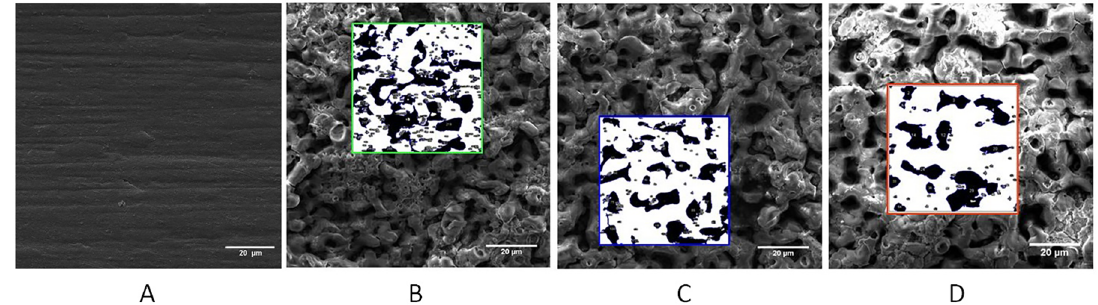
Figure 4. Scanning electron microcopy images and respective thresholds (highlighted) with a 2000x magnification, for the samples (A) untreated Al, (B) T